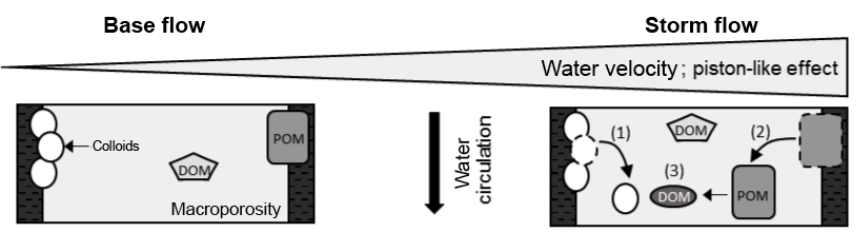
Figure 7. Schematic representation of DOM mobilization mechanisms involved during storm events in soils. Mobilization of DOM during storm flow conditions by (1) colloidal destabilization and/or (2) particulate destabilization combined with (3) chemical equilibrium